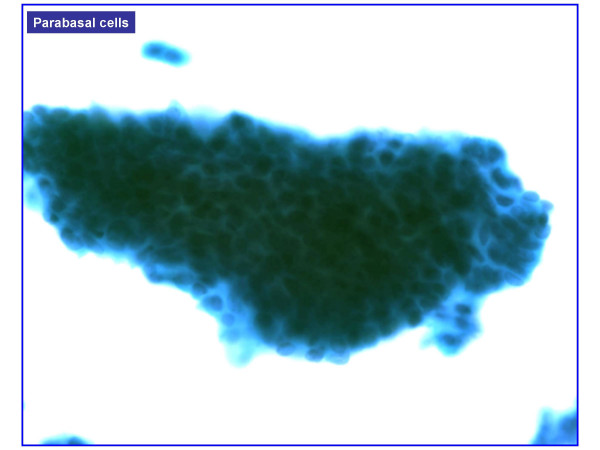
Parabasal cells, (100×).